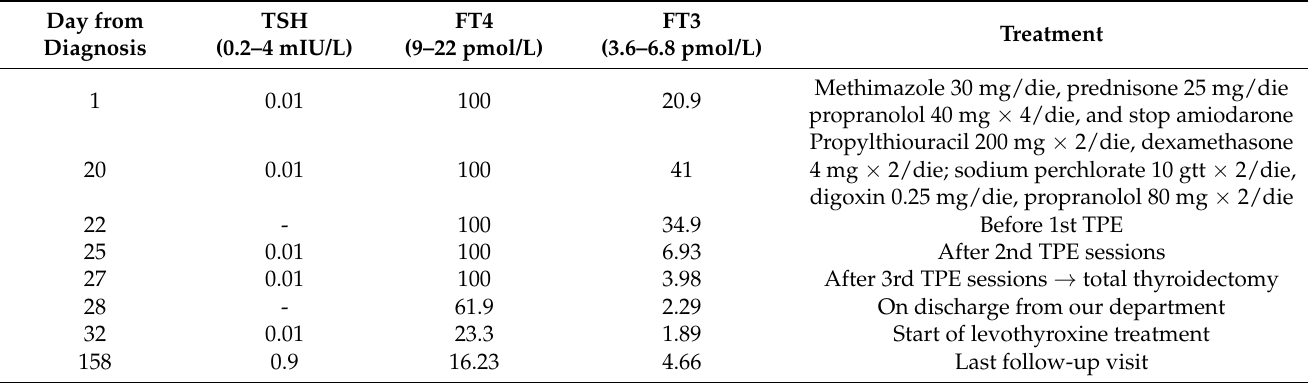
Table 1. Thyroid hormone status from the diagnosis in patient